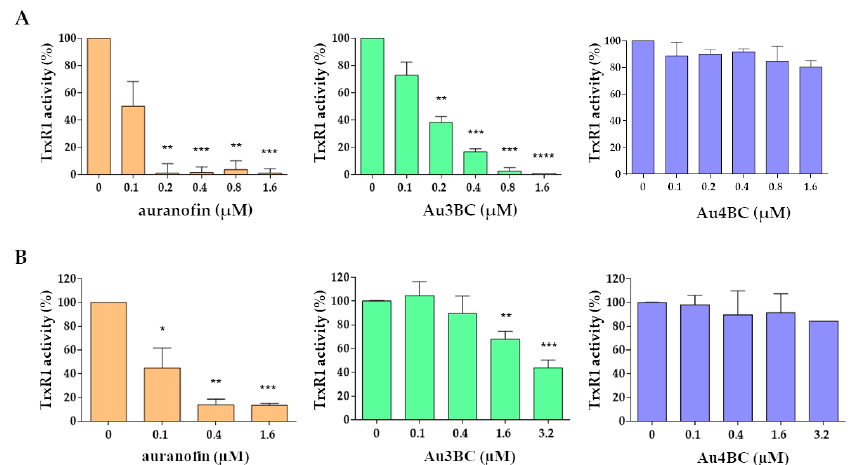
Figure 3 . Inhibition of TrxR1 activity by Au3BC and Au4BC in vitro. ( A ) recombinant rat liver